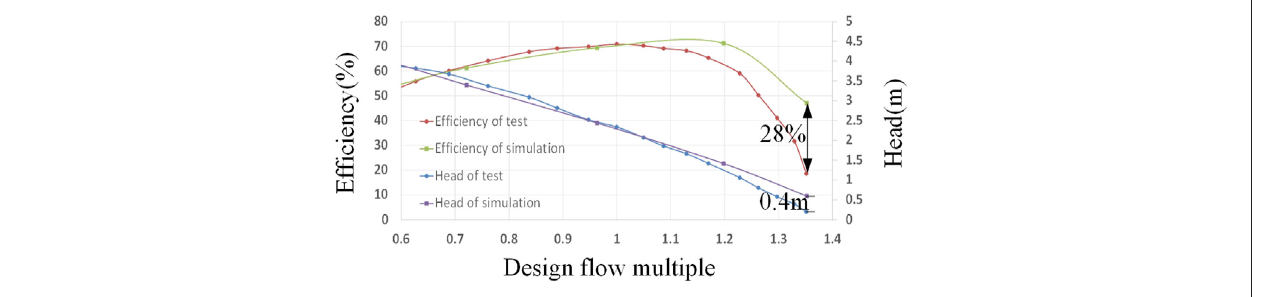
FIGURE 12 | Comparison of pressure fl uctuation.